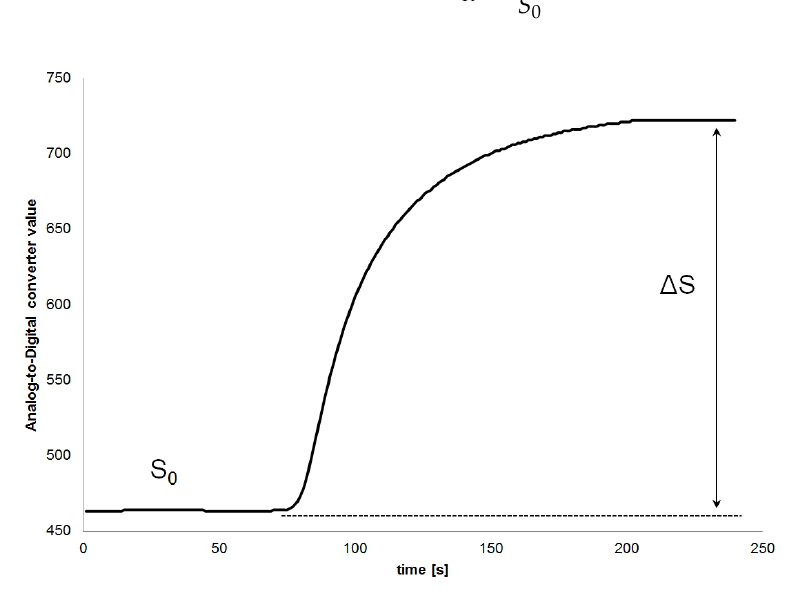
Figure 2. Example of the sensor